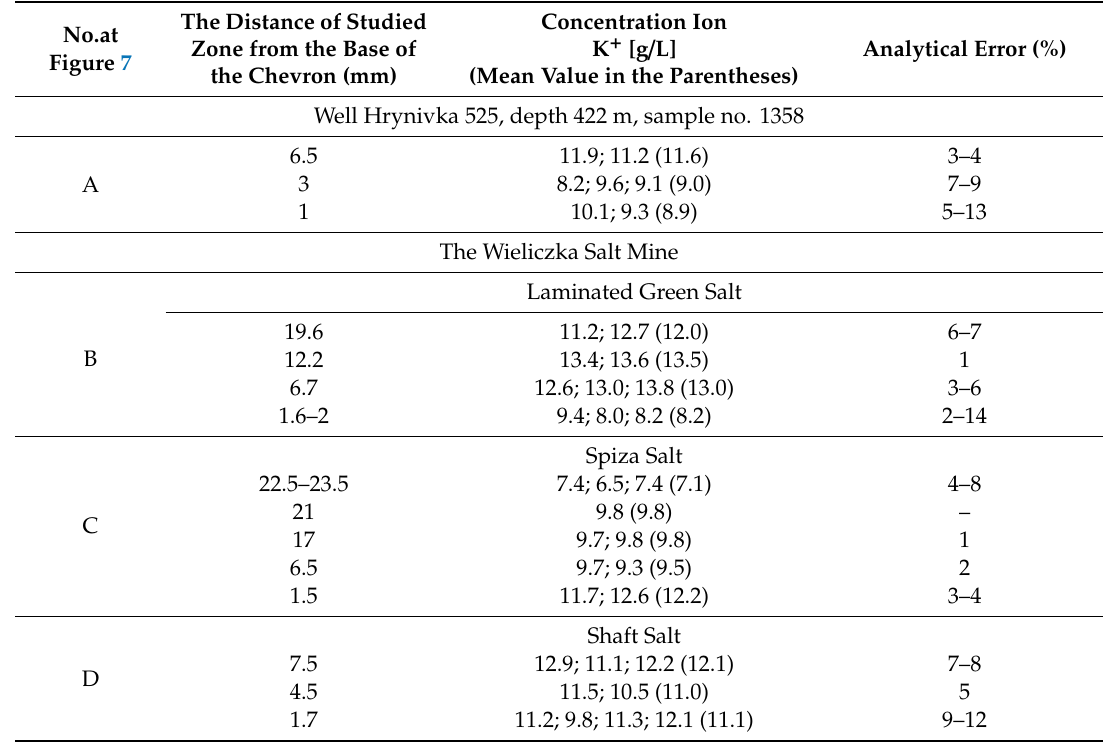
Table 2. The analytical error rate under the upgraded UMCA method, for a single determination of the K + content in the SO 4 -rich type of brine. Due to a small number of analyses ( < 10), errors were calculated via Student’s t-distribution. The chemical composition of sedimentary brine was studied based on the chevron halite inclusions from the Forecarpathian Basin (Well Hrynivka 525 and the Wieliczka Salt